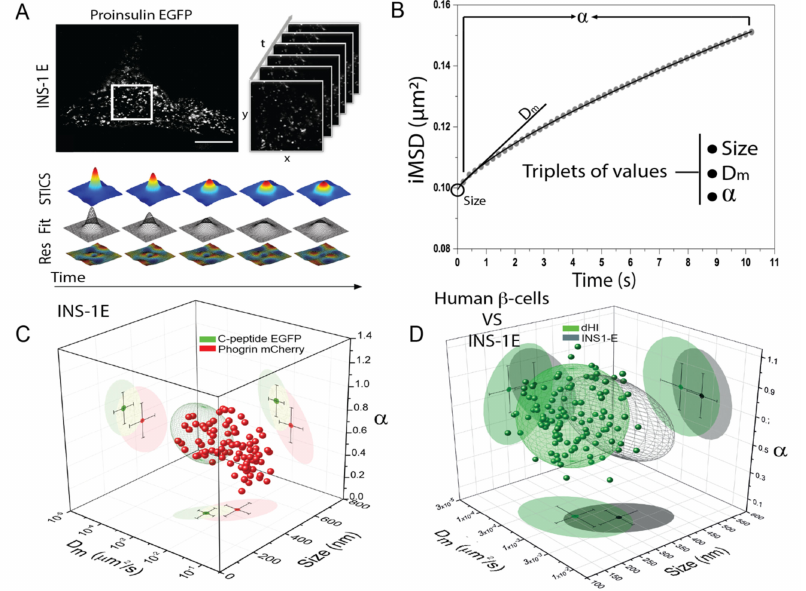
Figure 9. iMSD analysis on labelled ISGs in INS-1E and isolated human β -cells. ( A ) Example of INS-1E cell transfected with proinsulin-EGFP: the visible punctuated pattern represents the ISGs containing the GFP-tagged c-peptide fragment. iMSD analysis consists in a time lapse acquisition of a cytoplasmic region of the transfected cell. Spatio-temporal image correlation spectroscopy (STICS) analysis is then performed on the stack of images. ( B ) iMSD curve obtained by Gaussian fitting of the spatiotemporal correlation functions representing the average diffusion law of the whole population of captured ISGs. For each experimental curve, values of anomalous coefficient α , local diffusivity D m and size are extracted by fitting procedures. ( C ) Structural and dynamic properties of ISGs labelled with proinsulin-EGFP (green) and phogrin-EGFP (red) represented as a scatter plot in which the three values of α , D m and size of each acquisition are organized in a 3-D parametric space. ( D ) Comparison between syncollin-EGFP labelled granules in INS-1E cells (grey) and in dispersed human islet β cells (dHI). Adapted from Ferri et al.